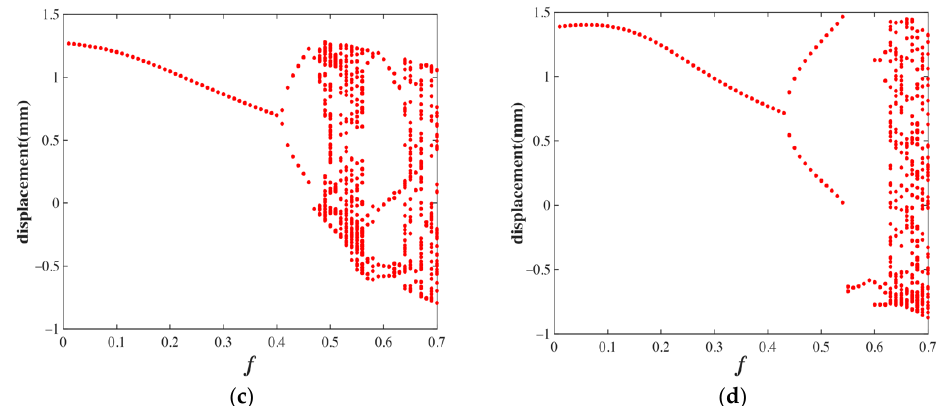
Figure 21. Local bifurcation diagram of the system with f at different orders α : ( a ) α = 0.5; ( b ) α = 0.8; ( c ) α = 1; ( d ) α = 1.3.